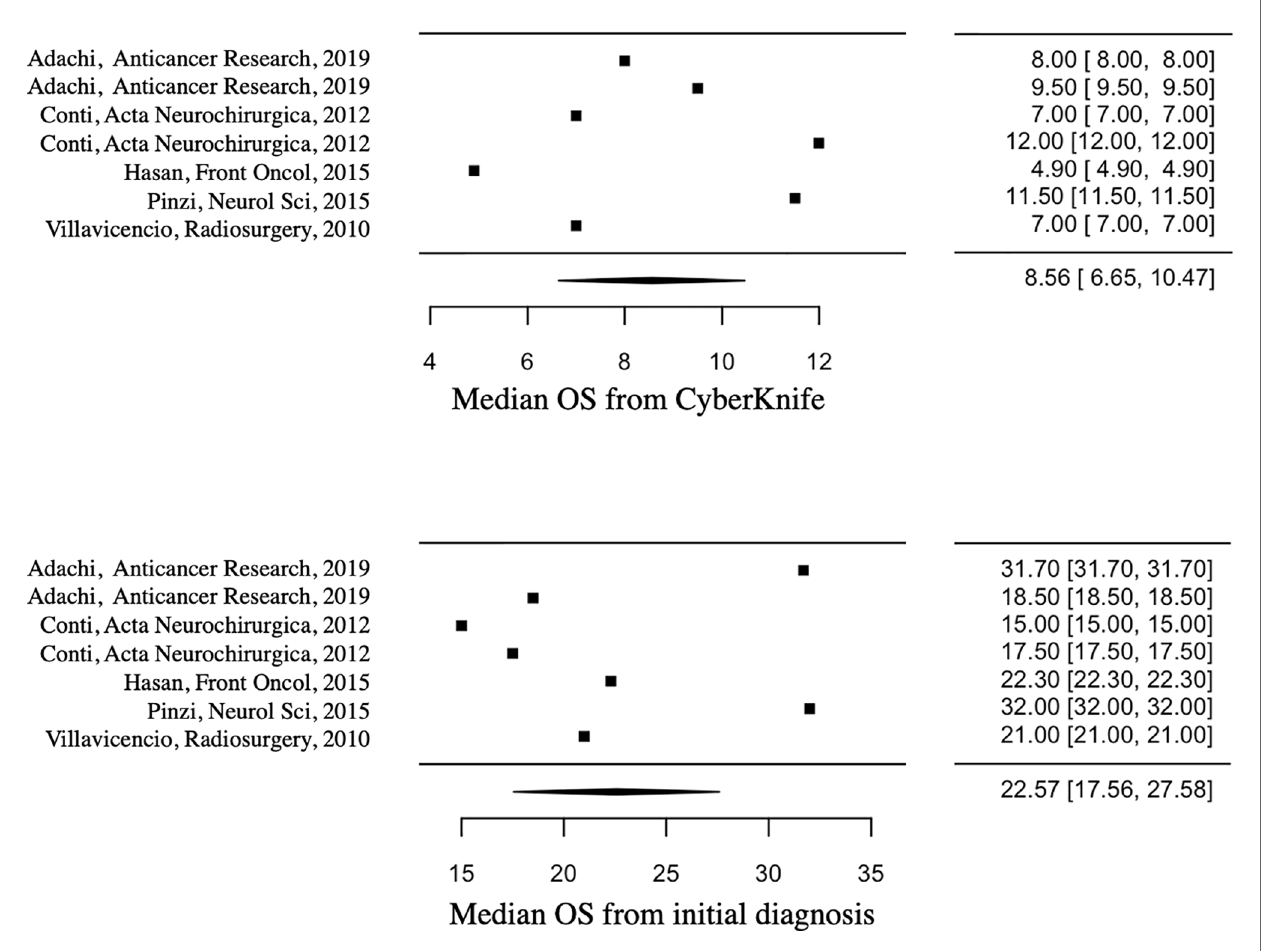
FIGURE 2 | Forest plots showing median OS from initial diagnosis (below) and CK treatment